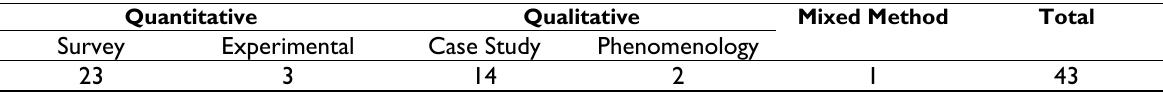
Table 5: Topics of Research